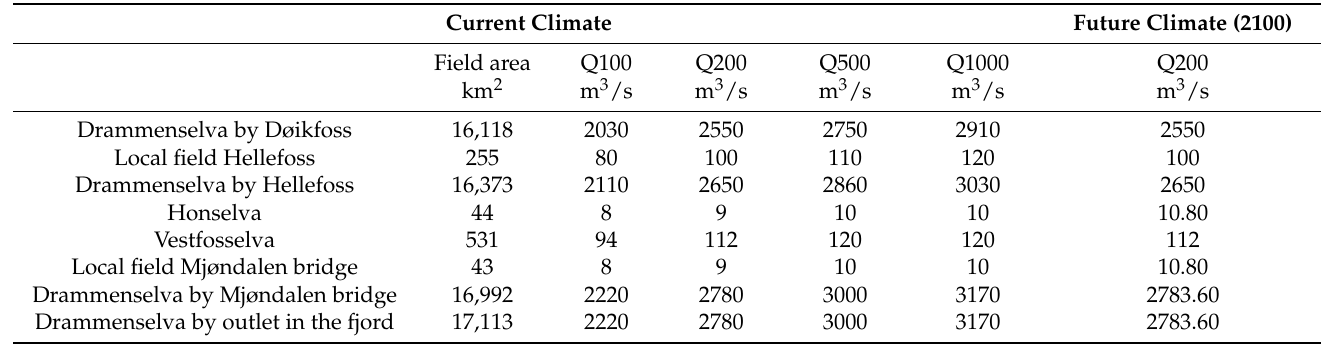
Table 2. Flood water flows in the Drammenselva River taken from NVE’s report